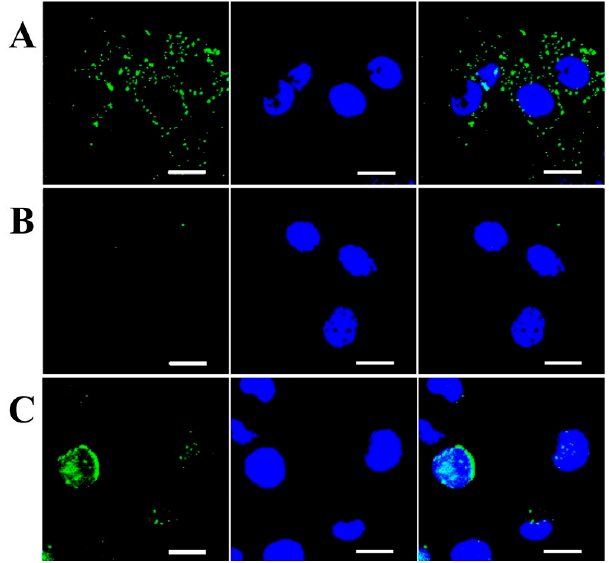
Figure 8. Confocal laser scanning microscopy of ( a ) A549, ( b ) NIHT3T, and ( c ) H22 cells incubated with FITC-labeled HA nanogels [83], The scale bar = 10 µ m. Reproduced with permission from Elsevier, 2015.